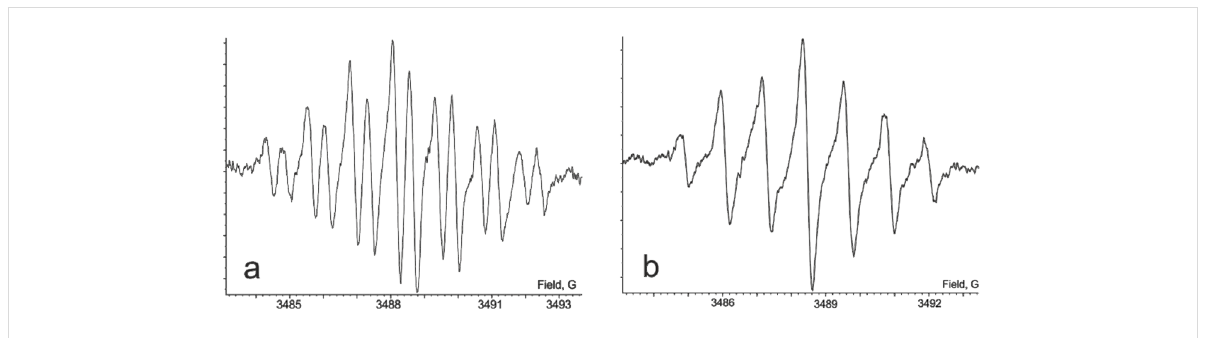
Figure 2: The EPR spectrum of (1 · )H in CHCl 3 , 293 K: a) experimental and b) experimental + D 2 O.